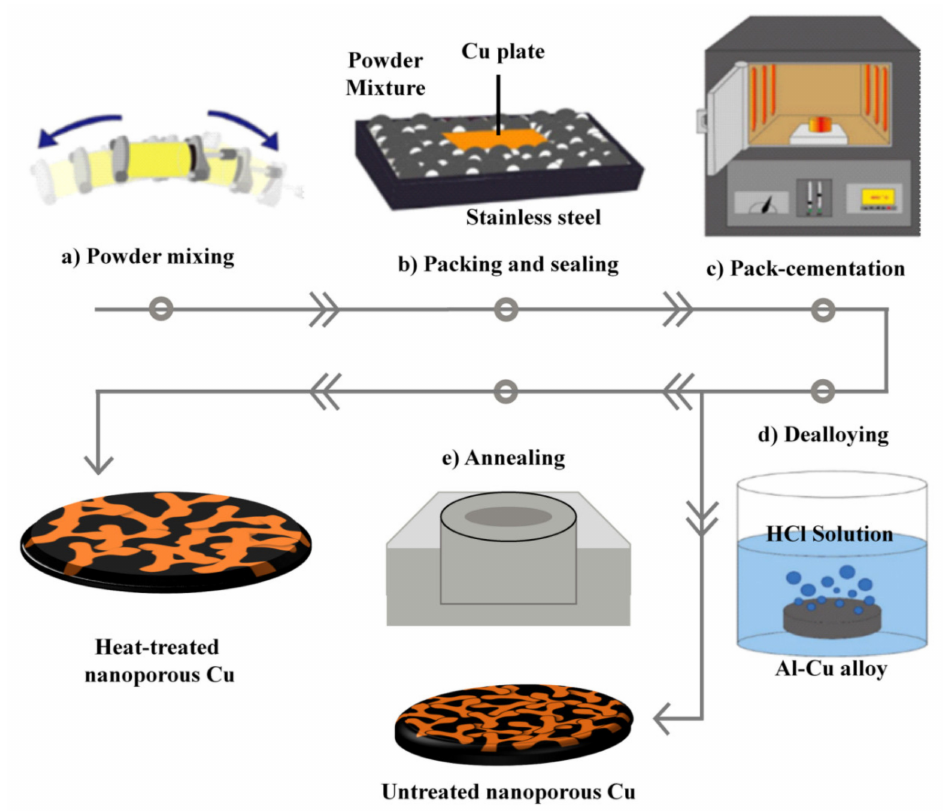
Figure1. Schematicdiagramofthenovelprocessingmethodproposedinthisstudytocreatenanoporous Cu foam using a pack cementation Al coating process on Cu